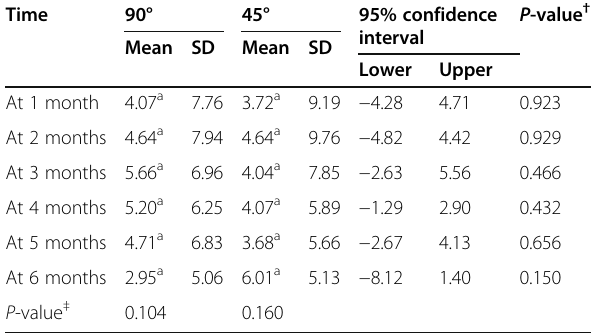
Table 1 Comparison of the PTV of 45° and 90° miniscrews over